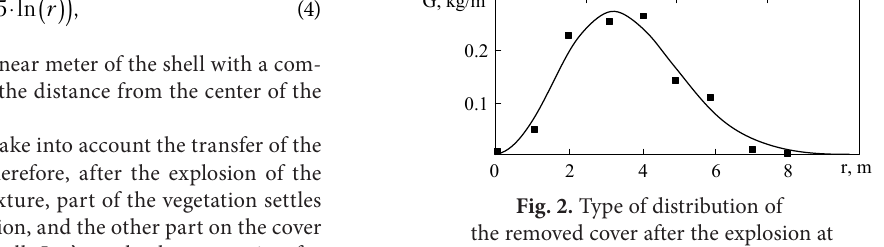
Fig. 2. Type of distribution of the removed cover after the explosion at m rc = 1 kg and a shell length of 1